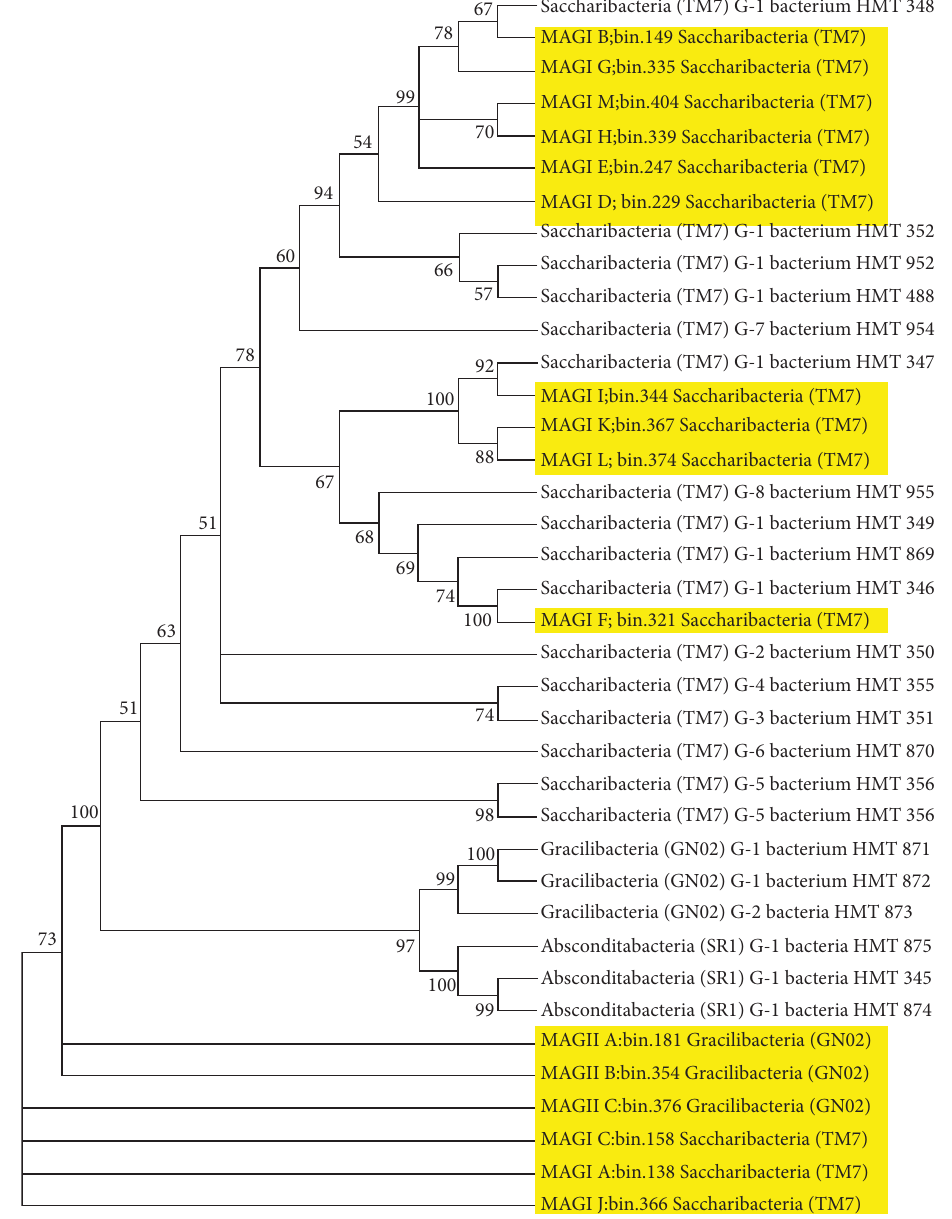
Figure 1: Phylogenetic relationships within the CPR of assembled in the study and derived from public ribosomal databases and available genomes using maximum-likelihood 16S rRNA. Highlights show CPR assembled for this study. Table 2: Comparison of CPR bins’ features in the original literature and in this